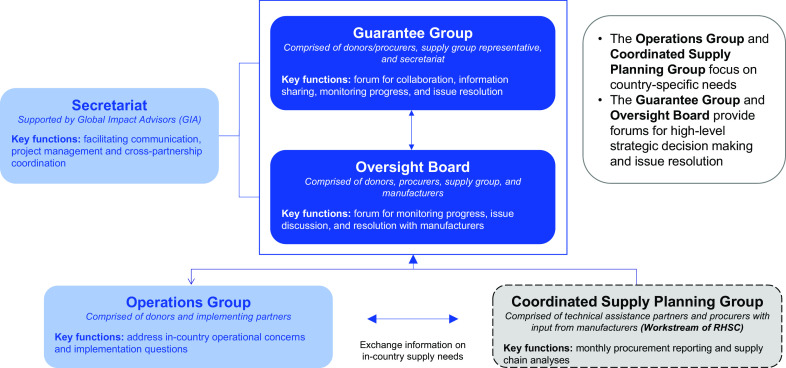
Implants Access Program Governance Structure